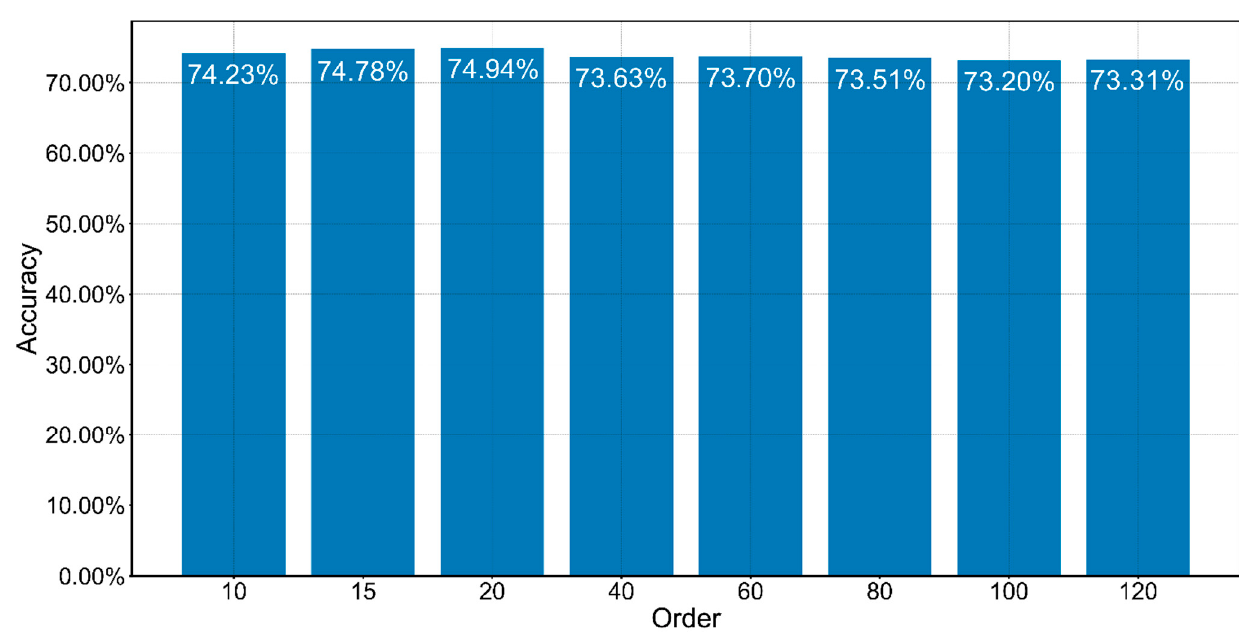
Figure 12. Order impact of MFCCs on the performance of the proposed model.